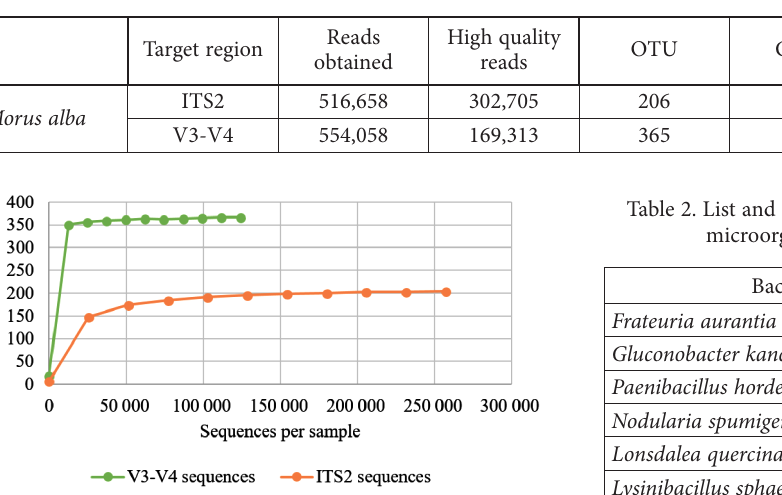
Table 1. Summary of ITS2 and 16S rRNA gene amplicon sequence analysis and microbial community diversity parameters